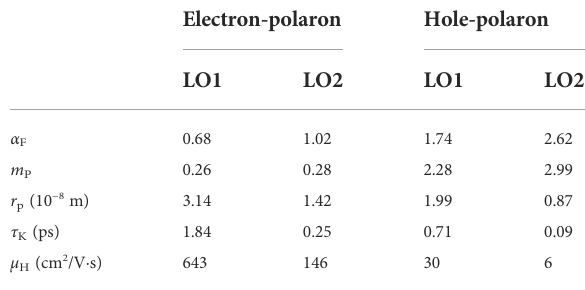
TABLE 2 Fröhlich constant α F , effective mass ｍ P , radius r p , lifetime τ Κ , and mobility μ Η of electron- and